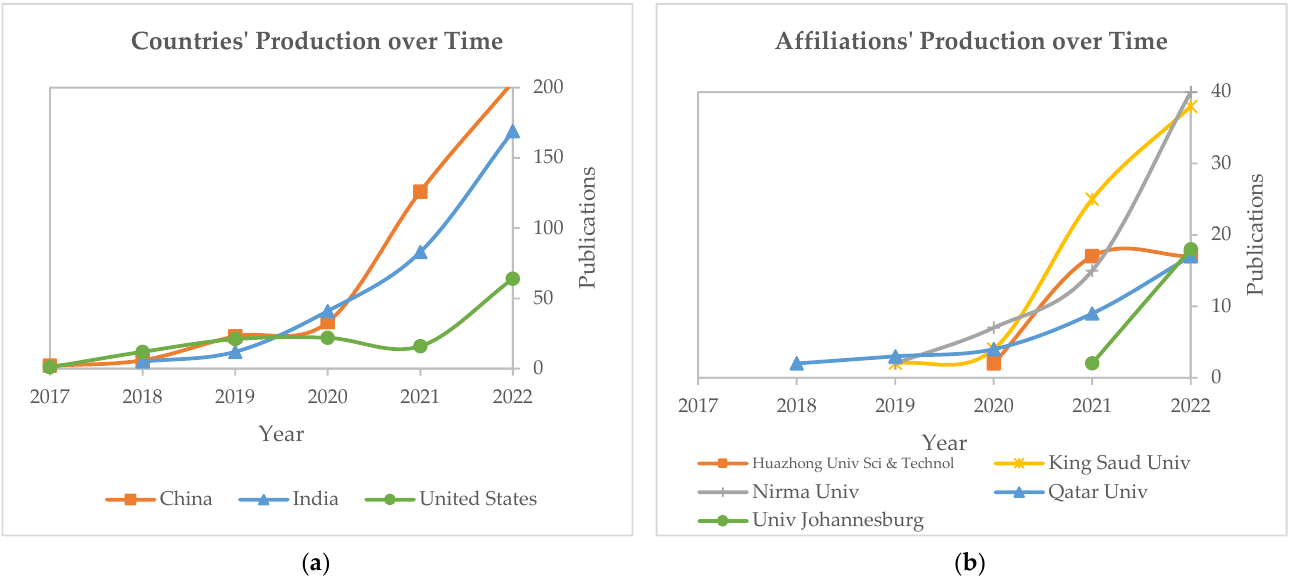
Figure 6. Evolution of scientific production by ( a ) countries; ( b ) organizations.